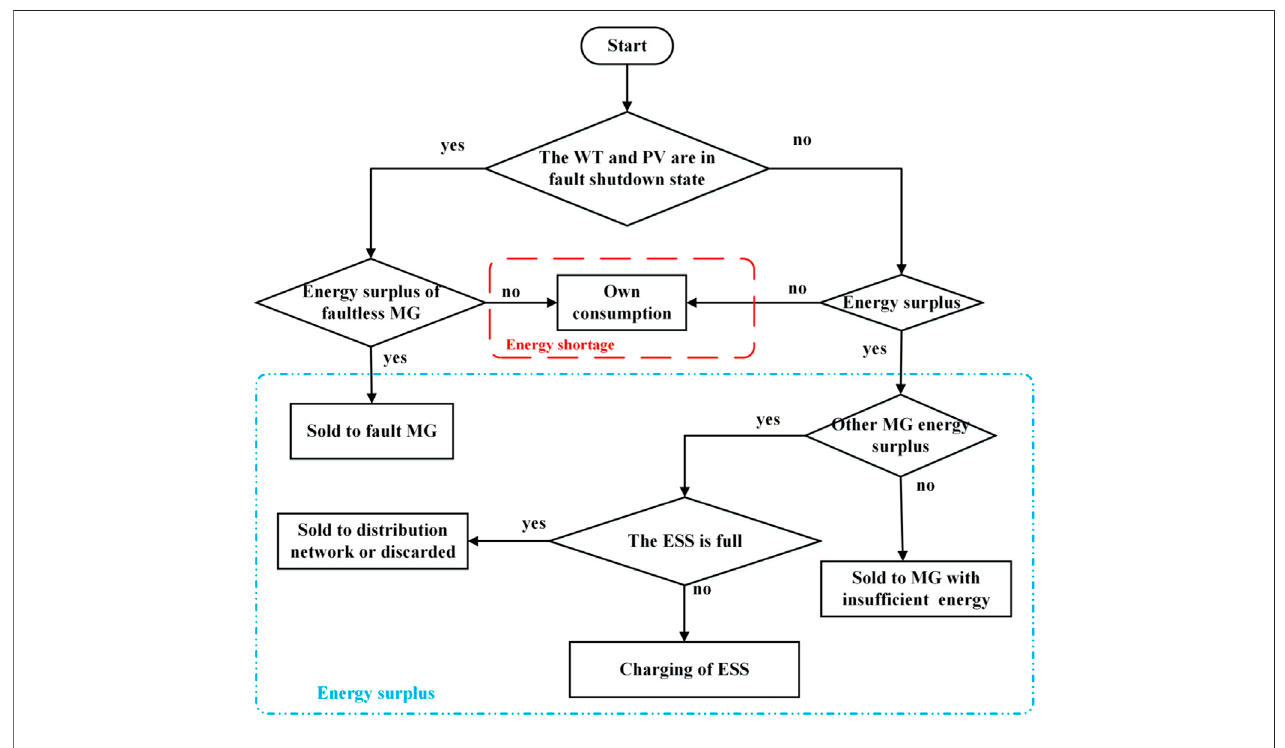
FIGURE 2 | Energy management strategy diagram.